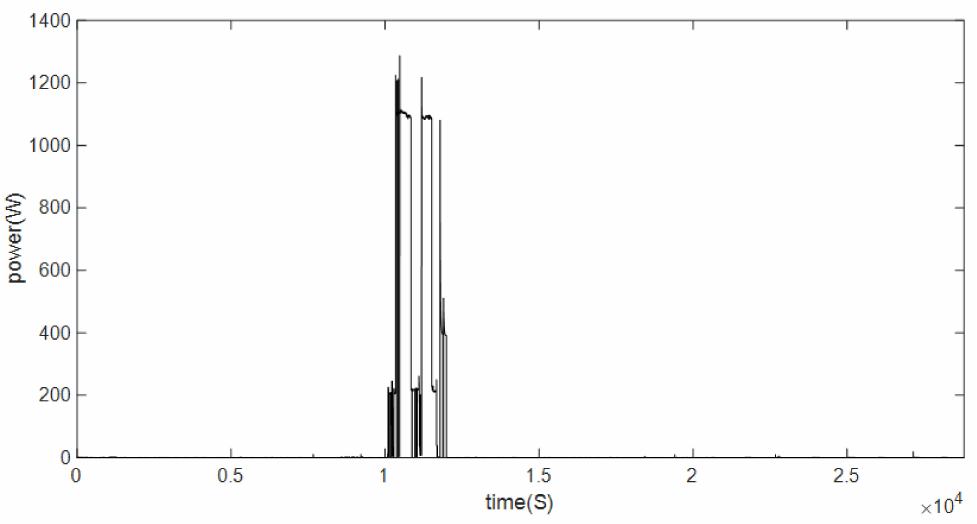
Figure 5. The actual daily energy consumption of Household 1’s